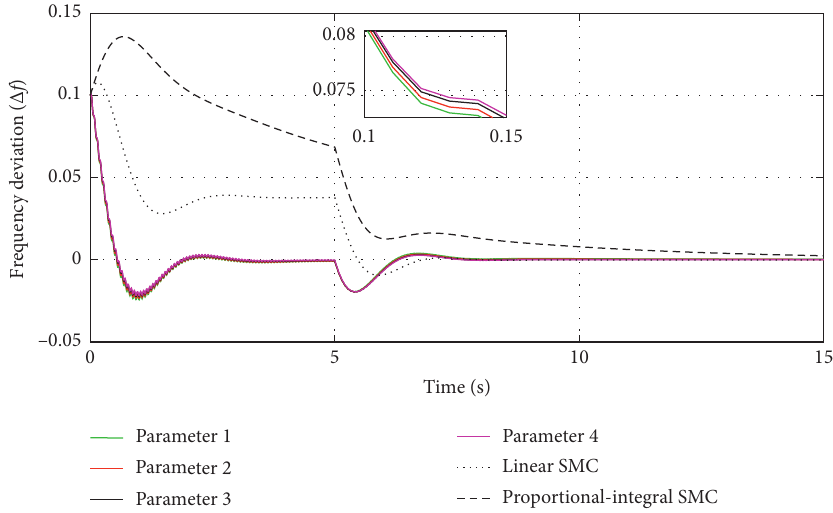
Figure 3: Frequency deviation with the step load attack. Table 2: The evaluation index of frequency